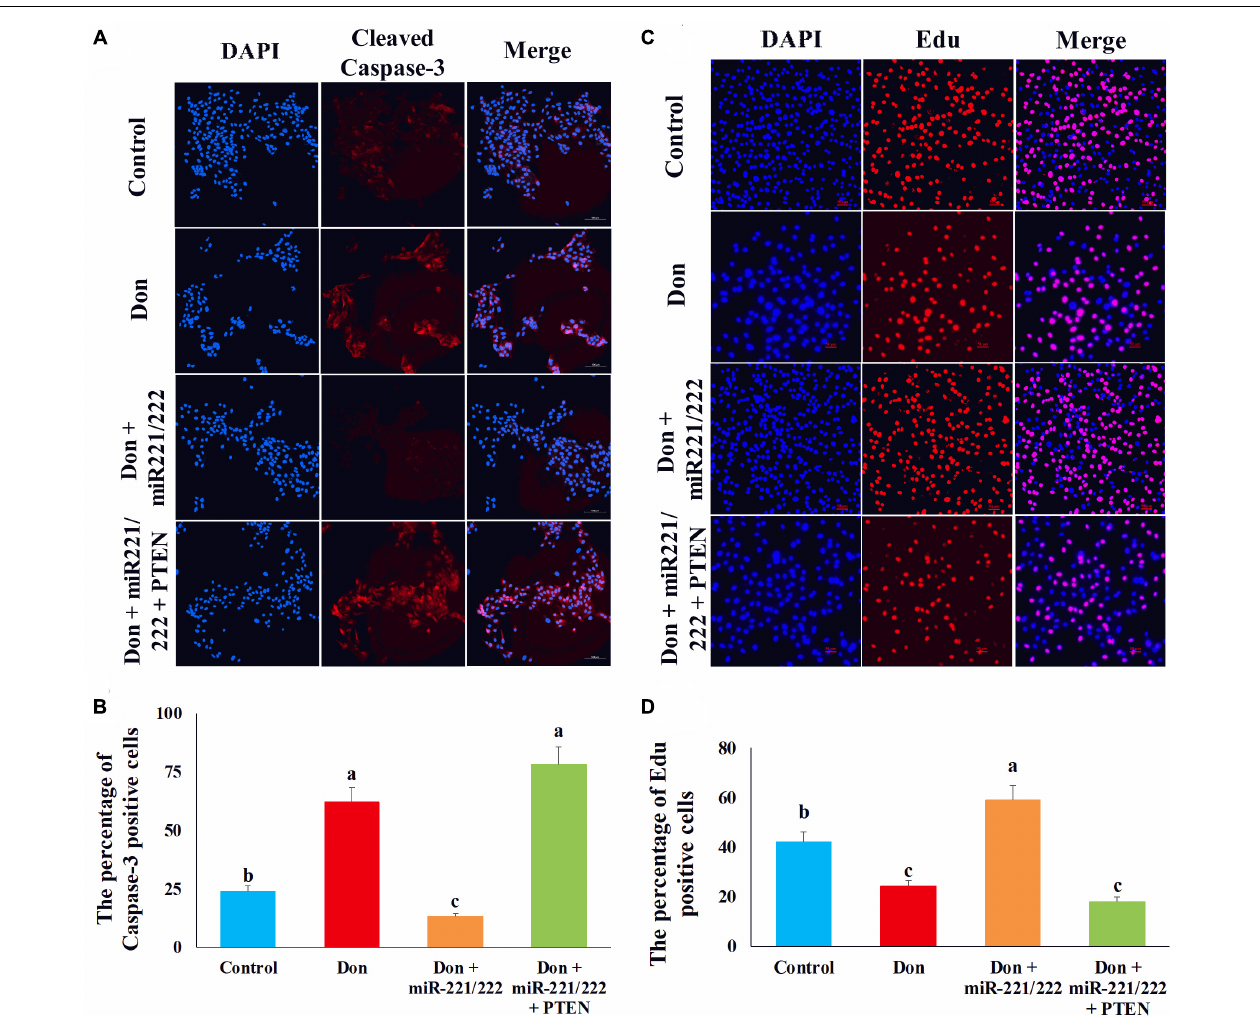
FIGURE 8 | MiR-221/222 protects intestinal epithelial cells against Don-induced apoptosis and proliferation inhibition by targeting PTEN. (A) Representative images of the caspase-3 immunofluorescent staining for apoptotic intestinal epithelial cells. Cleaved caspase-3: red, a molecular marker of apoptosis; DAPI: blue, cell nucleus; Merge: the apoptotic cells. (B) The quantitative result of (A) . (C) Representative images of the EdU staining for proliferating intestinal epithelial cells are shown. The cell nucleus was stained with DAPI, blue. Proliferating intestinal epithelial cells were labeled with EdU fluorescent dye (red). (D) The quantitative result of (C) . Our results were presented as mean ± SEM of triplicate independent experiments for each group. Bars with different letters indicate they are significantly different ( p < 0.05). In (A) , magnification = × 100; the scale bar on the photomicrographs represents 100 µ m. In (B) , magnification = × 100; the scale bar on the photomicrographs represents 100 µ m. Don, IPEC-J2 cells were exposed to 1.6 µ g/ml Don for 12 h. Don + miR-221/222, IPEC-J2 cells were transfected with 80 nM miR-221/222 mimics for 24 h, then exposed to 1.6 µ g/ml Don for 12 h. Don + miR-221/222 + PTEN, IPEC-J2 cells were transfected with 80 nM miR-221/222 mimics and 1.5 µ g/ml pcDNA3.1-PTEN for 24 h, then exposed to 1.6 µ g/ml Don for 12